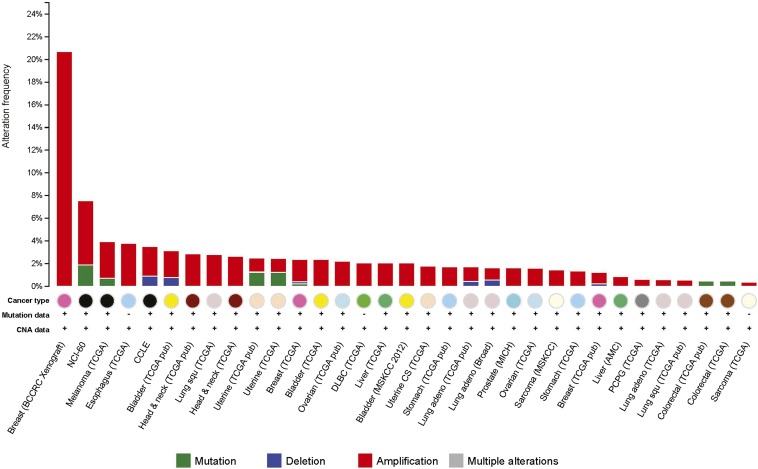
Amplification of the BAG2 gene was observed in many human tumors.Percentage of tumors showing genetic alterations, including amplification (red), mutation (green) and deletion (blue), in the BAG2 gene in different human tumors. Data were obtained from the cBioportal for Cancer Genomics (http://www.cbioportal.org).